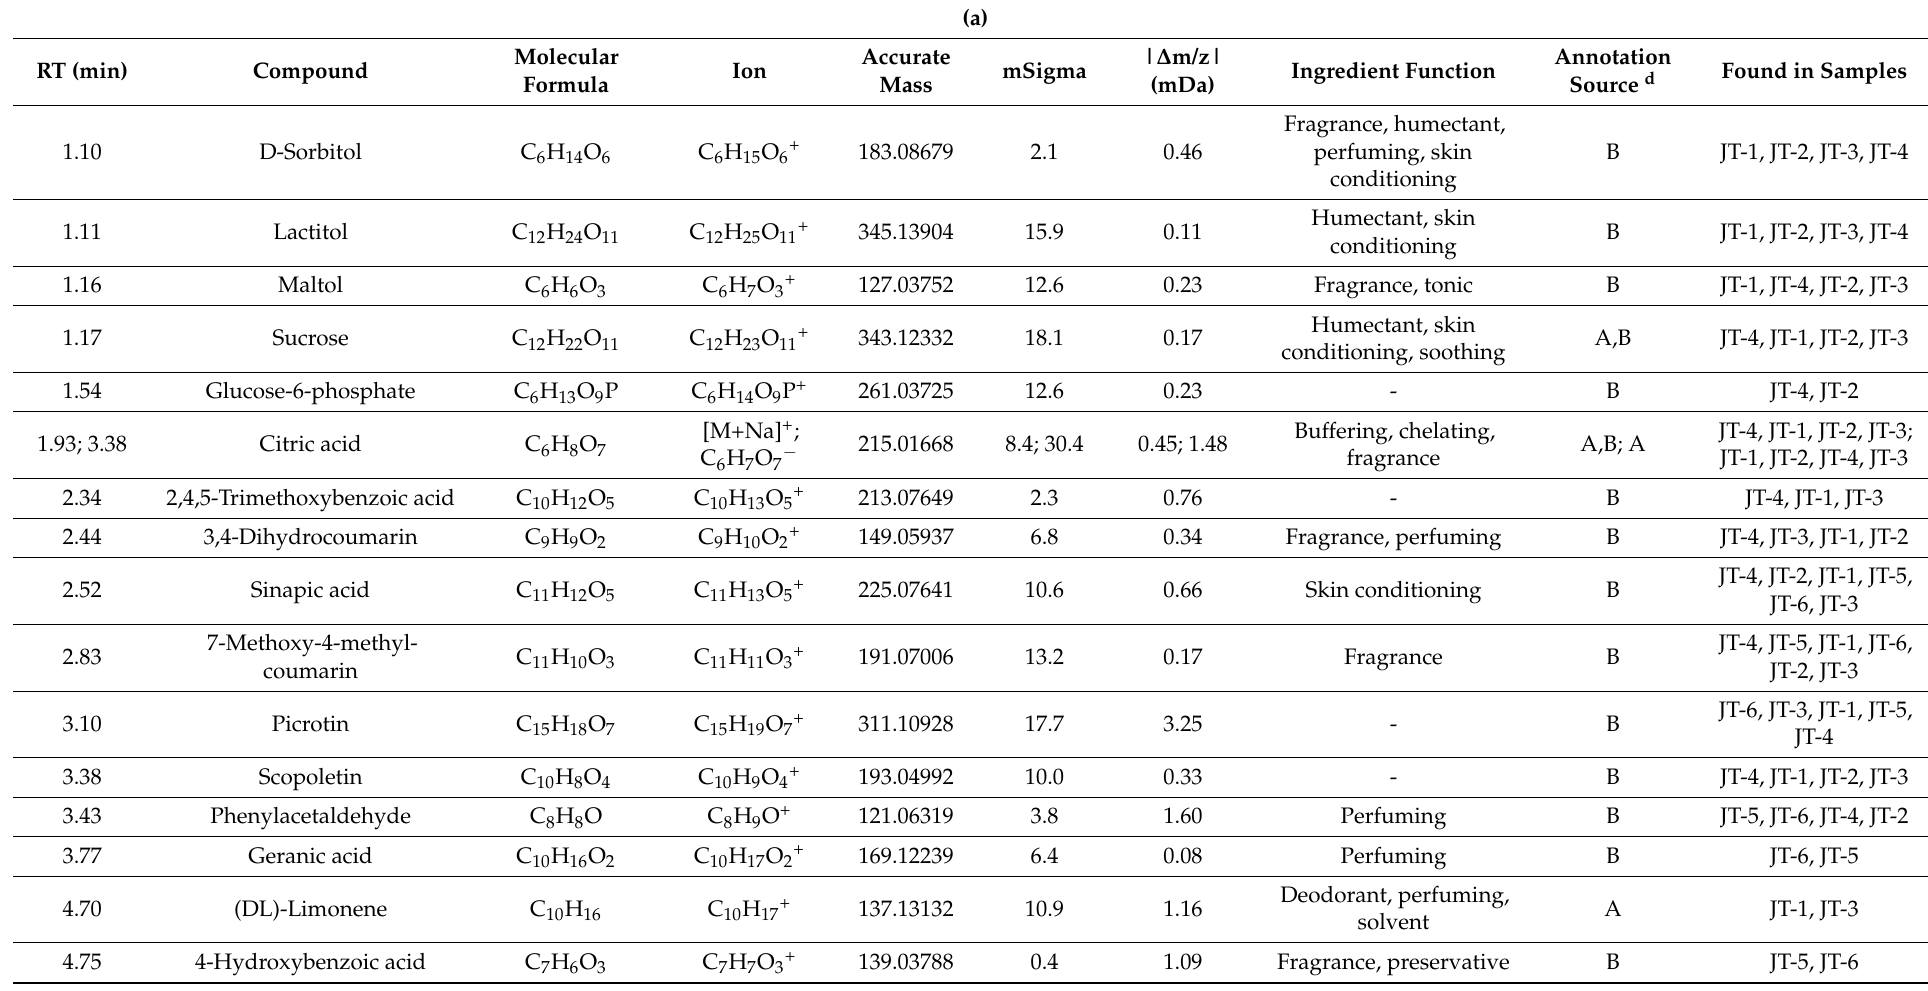
Table 5. Compounds identified by untargeted characterization applying fine-tuning strategies. ( a ) Jagua samples. ( b ) Henna samples. ( c ) HPT sample. d (A) Analyte List, (B) Spectral